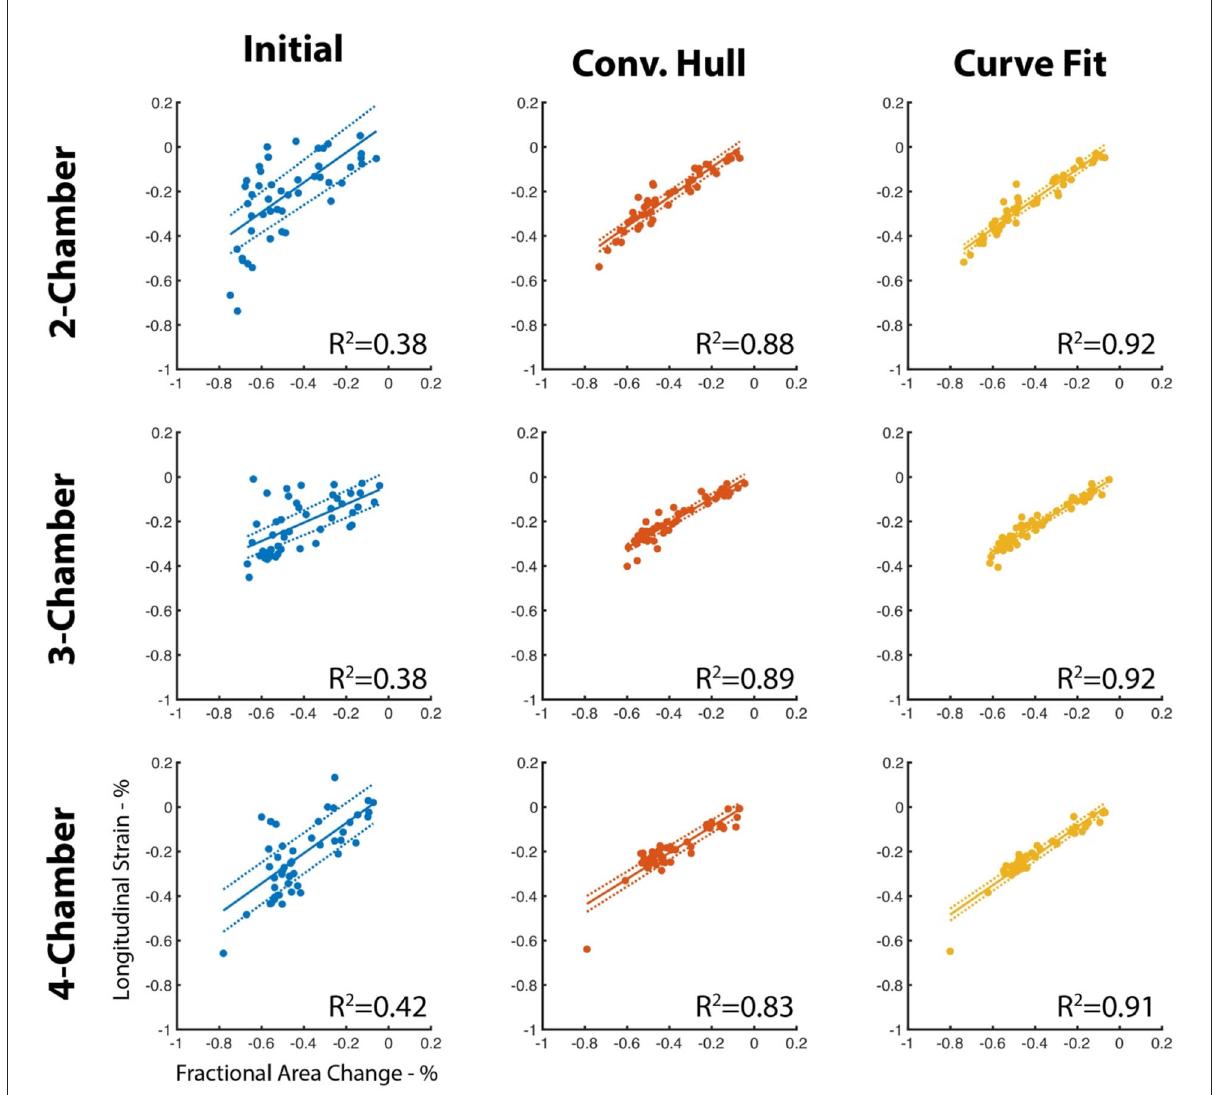
FIGURE4 Agreement between LS and FAC increases with use of the convex hull and perimeter curve fitting. The perimeter measured using our deep learning method is susceptible to artifacts due to the insertion points of the papillary muscles and by the texture of the endocardial surface. Use of a convex hull to “fill” in the papillary insertions and curve fitting of the surface improves agreement ( R 2 ) with fractional area change of the corresponding long-axis view. Dotted lines represent the 95% confidence interval of the linear fit.